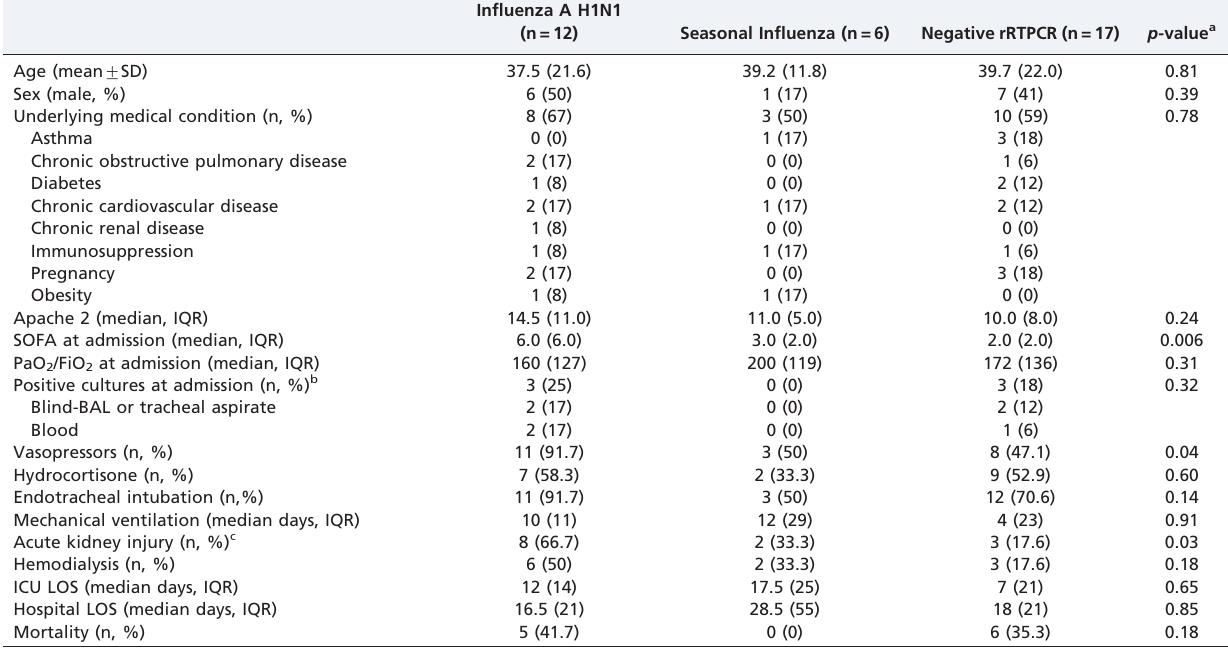
Table 1 - Patients’ main characteristics.